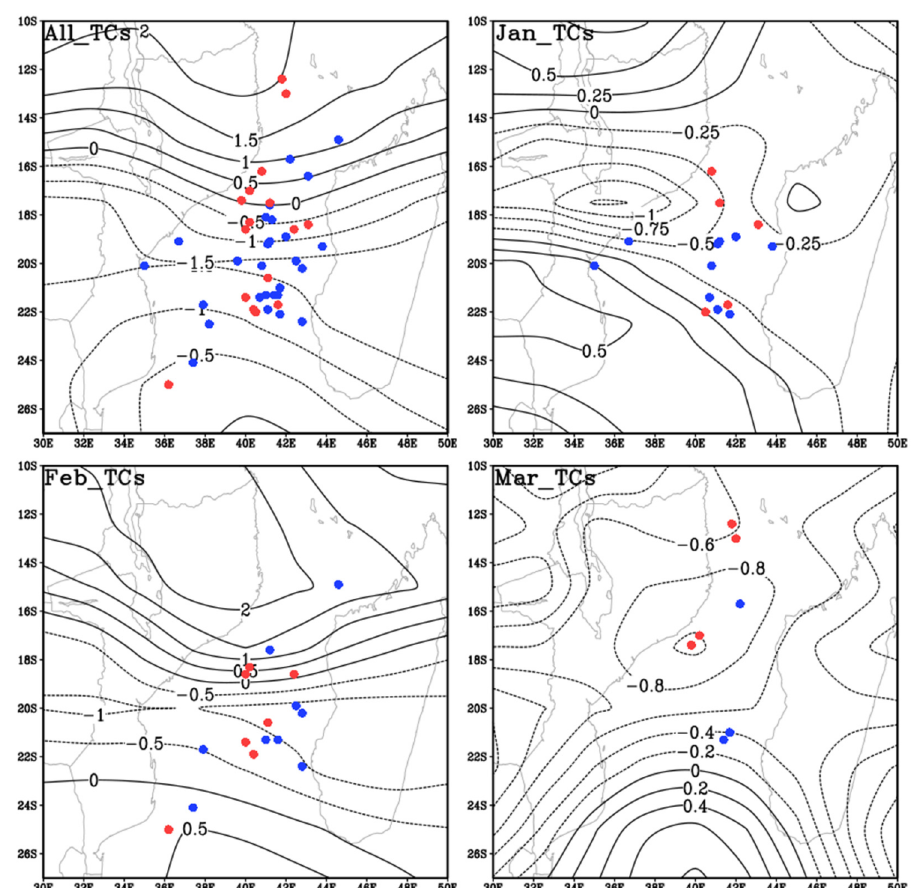
Figure 5. VWS monthly anomaly (contours in m/s) and the geographical distribution of TC genesis events (blue dots indicate monthly distribution and red dots the systems that intensified to at least TC intensity) for the period 1979–2019. Doted lines indicate negative values.